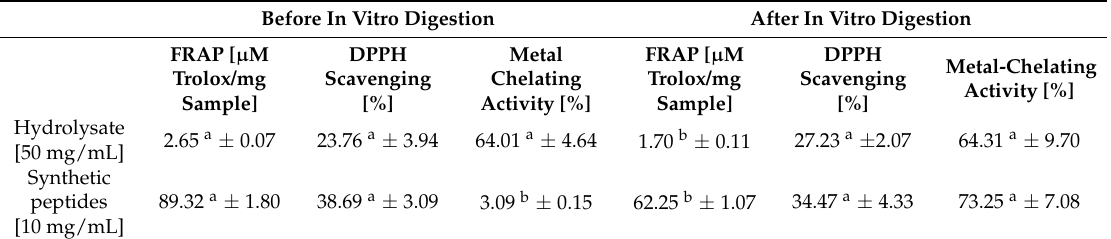
Table 3. Antioxidant properties of the hydrolysate and the synthetic Ala-Tyr peptide as well as their stability after in vitro